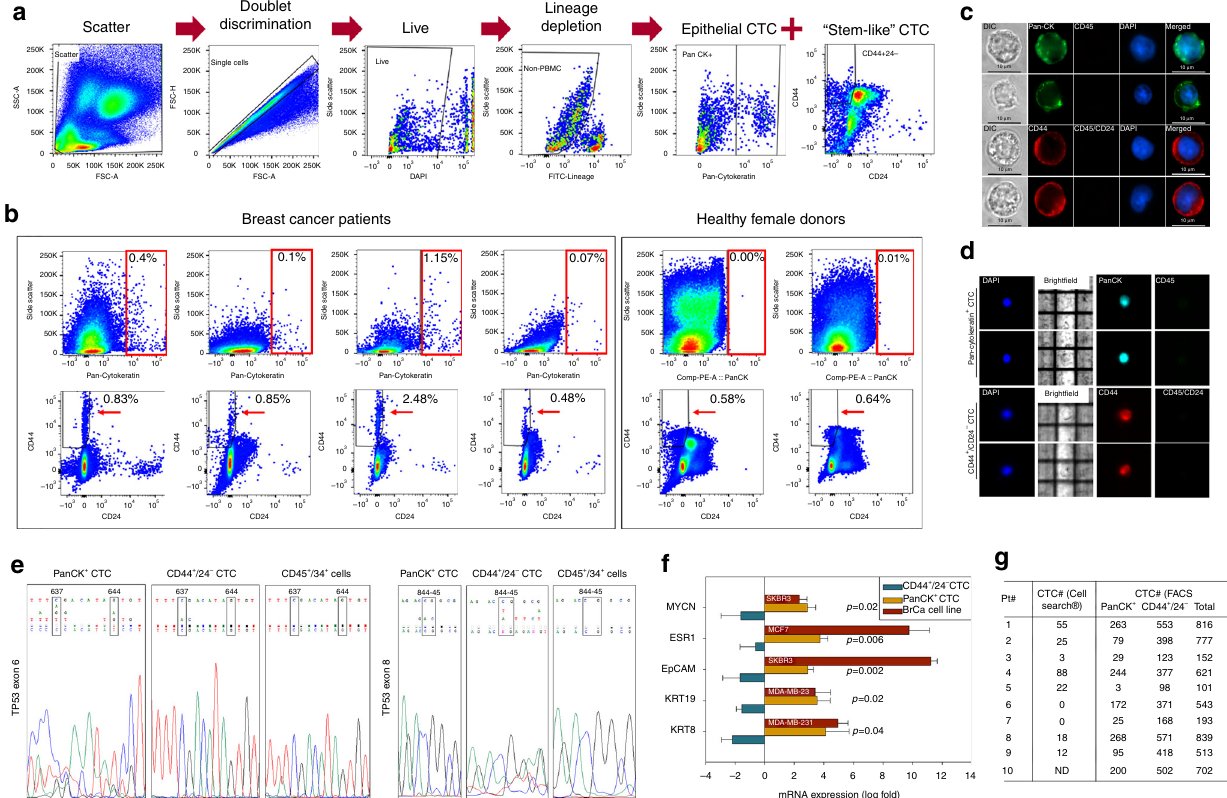
Figure 1 The isolation of CTCs from blood of breast cancer patients using multi-parametric fl ow cytometry. a Flowchart depicting the strategy for isolating breast cancer CTCs by multi-parametric fl ow cytometry. FITC lineage markers included: CD45 — leukocyte, CD73 — lymphocyte, CD34 — endothelial cell, CD105 — macrophage, fi broblast, and CD90 — mesenchymal stem cell, hematopoietic stem cell, natural-killer cell. b Multi-parametric fl ow cytometry gating used to isolate epithelial and stem-like breast cancer CTCs (PanCK+, CD44+/CD24 − cells) from blood of breast cancer patients. Red boxes ( upper panels ) and arrowheads ( lower panels ) highlight the absence of these cells applying the same procedures in corresponding blood from healthy female donors. c Immuno-cytochemical visualization of patient-derived CTCs by cytoplasmic/cell surface biomarkers. Scale bar = 10 μ m. d Representative images of CTC isolated by the DEPArray TM . e Chromatogram showing TP53 hotspot mutations in isolated CTCs. Upper panel : wild-type sequence; lower panel : sequence reads from patient-derived samples. Note the multiple nested peaks of different nucleotides in the boxed cDNA positions. Shown are also patient-derived “ normal ” CD45+/34+ cells (control) that underwent whole-genome ampli fi cation to ensure that altered sequence reads did not arise from the ampli fi cation process. f mRNA expression pattern of epithelial and neoplastic markers in isolated CTCs. Error bars represent s.e.m. ( n = 3); p- value calculated by student ’ s t -test. g Summary of CTC number and biomarker parameters in the investigated patient cohort. ND — CTC enumeration not determined on patient#10. Clinical parameters for these patients are provided in Supplementary Table